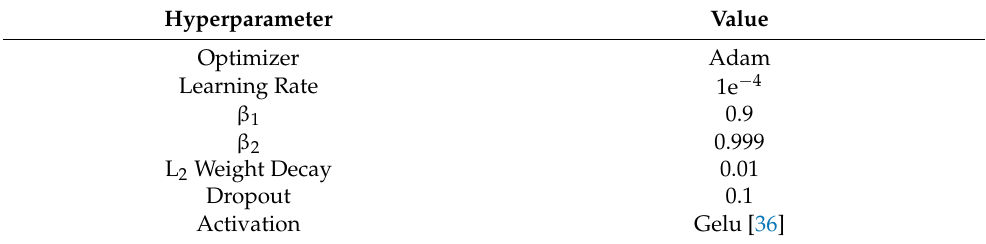
Table 1. BERT pre-training